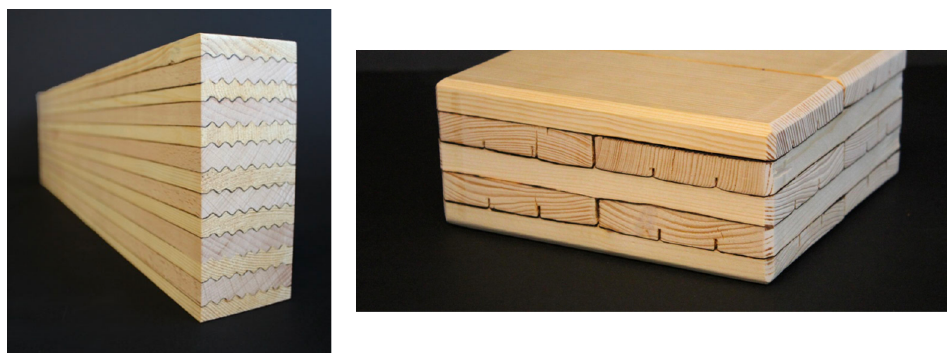
Figure 20. Potential industrial applications of the linear friction-welding technique in the form of multi-layered beams ( left ) and CLT ( right ) [137].